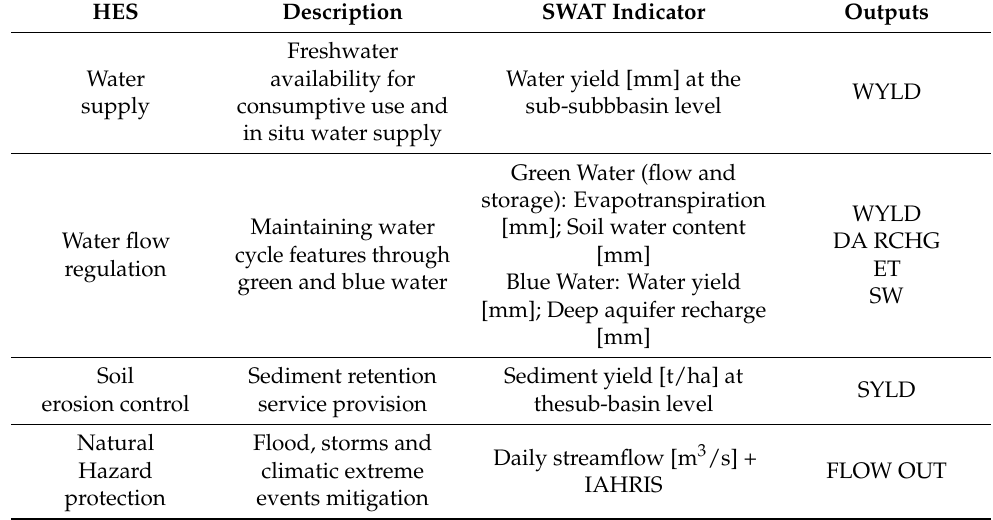
Table 2. Indicators based on SWAT output parameters (Adapted from